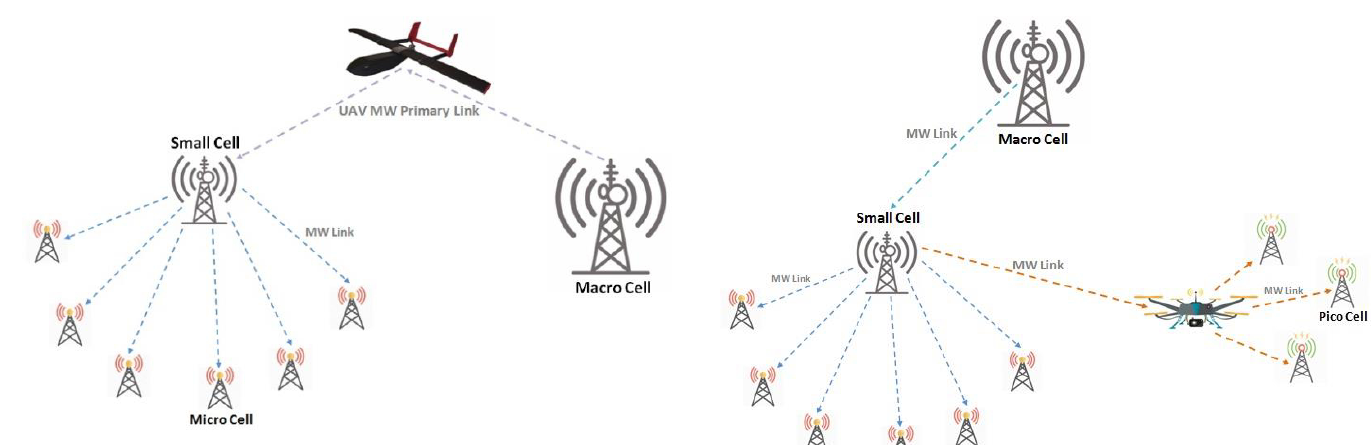
Fig 8. UAV supported macro to small cell primary link UAV Assisted Macro to Small Cell Backhaul or Supportive Link